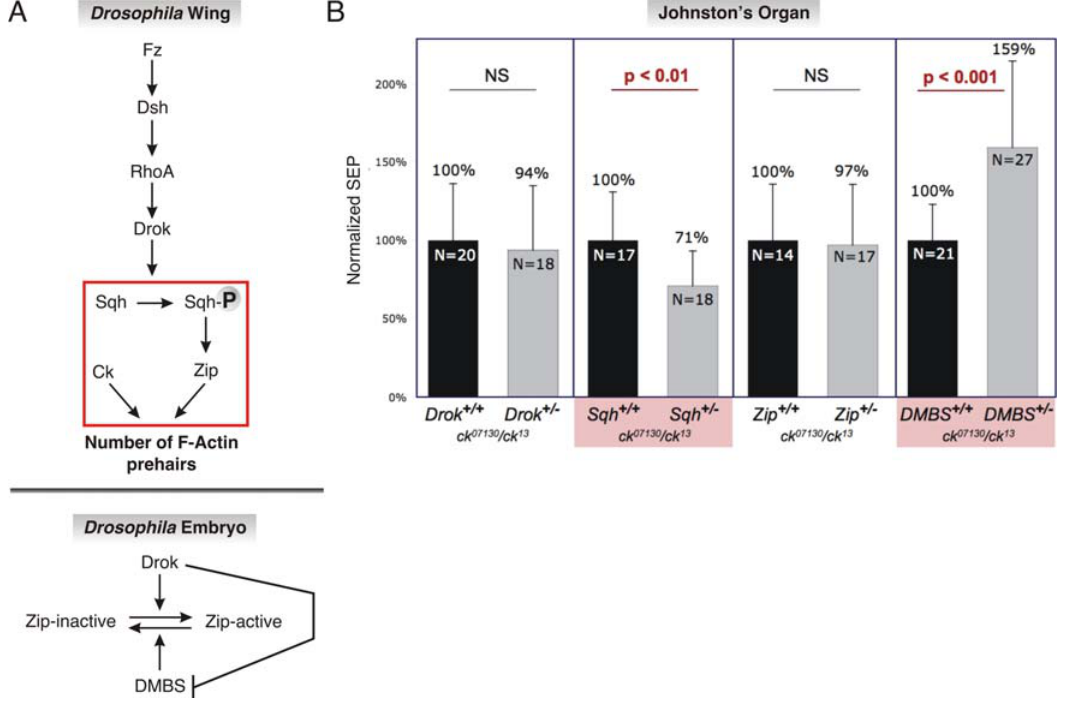
Figure 5. ck /MyoVIIA function is modulated by Sqh and DMBS in adult JO. A: Genetic interactions of ck /MyoVIIA with actin pathways in the Drosophila wing (top panel) and in embryonic dorsal closure (bottom panel). Boxed area indicates the portion of the pathway investigated in panel B. Based on [26,36]. B: ck /MyoVIIA genetically interacts with Sqh and DMBS in adult JO. Responses from flies with only one functional copy of Drok , sqh , zip /MyoII or DMBS were normalized to their respective, two-copy sibling controls, all in a sensitized ck /MyoVIIA background. Histograms show mean + / 2 SD.